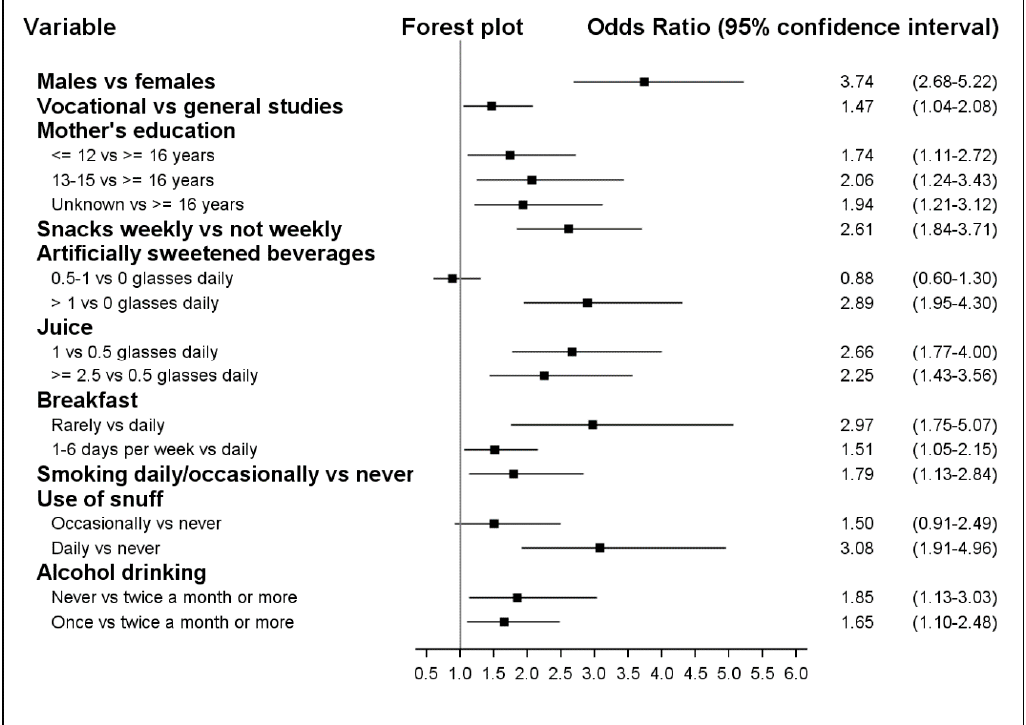
Figure 2. Odds for being a daily drinker of sugar-sweetened beverages in the Tromsø study: Fit Futures . Mutually adjusted model including sex and mother’s education, n = 870.